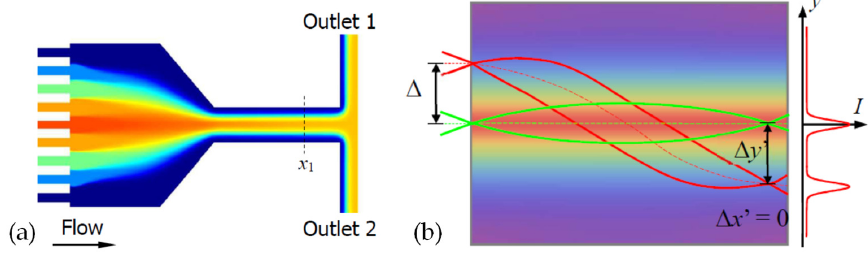
Figure 29. Multichannel mixing GRIN lens. ( a ) The structure to form the refractive index distribution, and ( b ) the equivalent optical path diagram of the graded refractive index lens [135]. Reprinted with permission from Ref. [135]. 2016 Royal Society of Chemistry.